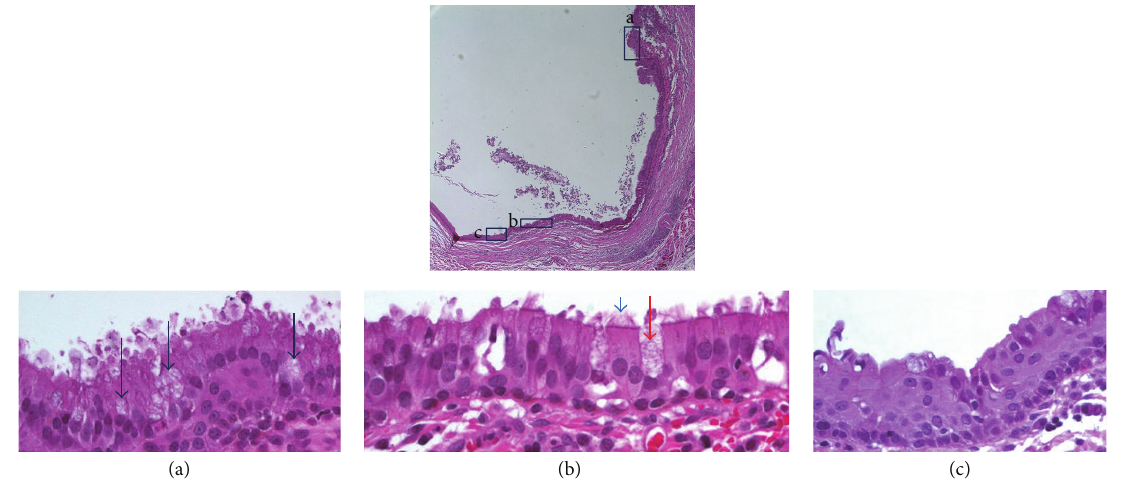
Figure 3: The cyst is covered by ciliated columnar epithelium with mucin vacuoles under low-power magnification (40x). (a) Mucin vacuoles are observed with ciliated columnar epithelium (dark blue arrows); hematoxylin and eosin (400x). (b) The inset shows cilia on both the top portion (blue arrow) and the lateral borders (red arrow) of the columnar cells (400x). (c) Squamous metaplasia (400x).